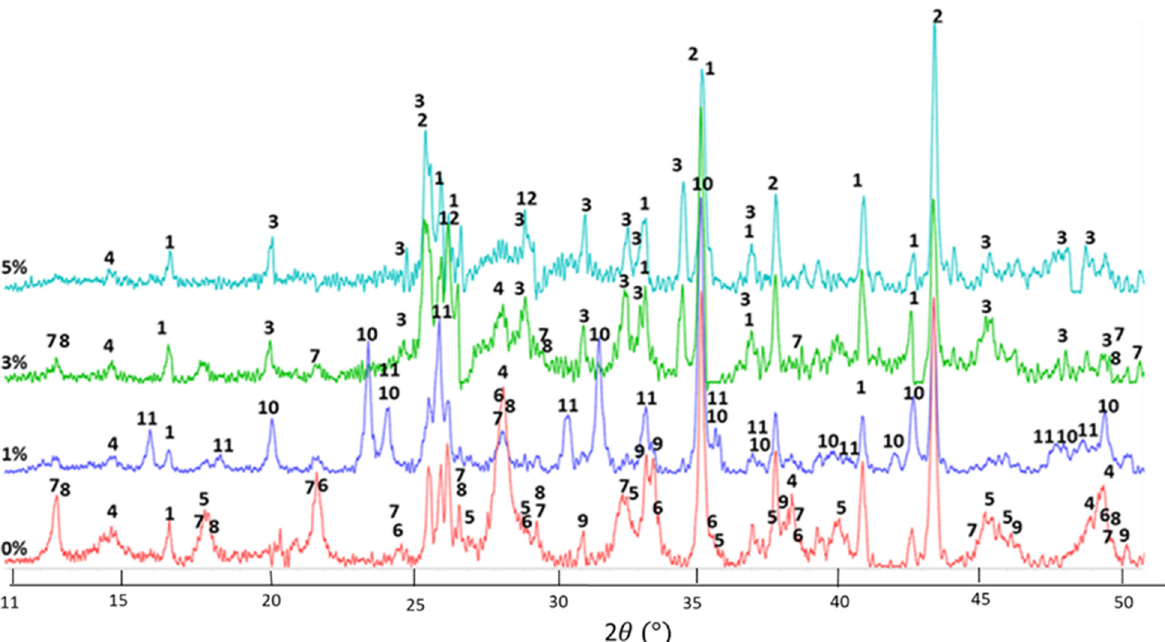
Figure 24. XRD patterns for 250 °C-autoclaved CAC samples containing 1, 3, and 5% PMHS-treated and untreated FCSs: No.1 mullite (ICDD#04-016-1586, Al 2.22 Si 0.78 O 4.89 ), No.2 corundum (01-073-1512, Al 2 O 3 ), No.3 grossite (01-072-0767, Ca(Al 4 O 7 )), No.4 boehmite (01-073-6509, AlOOH), No.5 katoite (04-014-9841, Ca 3 Al 2 (SiO 4 ) 1.53 (OH) 5.88 ), No.6 anorthite (01-089-1477, (Ca 0.98 Na 0.02 )(Al 1.98 Si 0.02 )Si 2 O 8 ), No.7 gismondine (01-076-8378, Ca 4 (Al 8 Si 8 O 32 )(H 2 O) 19 ), No.8 gobbinsite (01-079- 6023, (Na 4.74 Ca 1.23 )(Al 5.65 Si 10.35 O 32 )(H 2 O) 10.9 ), No.9 garronite-Na (04-023-2956, Na 3 Al 3 Si 5 O 16 (H 2 O) 3.6 ), No.10 dmisteinbergite (04-011-5220, CaAl 2 Si 2 O 8 ), No.11 analcime (04-011-7963, Na 8 Al 8 Si 16 O 48 (H 2 O) 8 ), and No. 12 silica (04-008-8437, SiO 2 ).